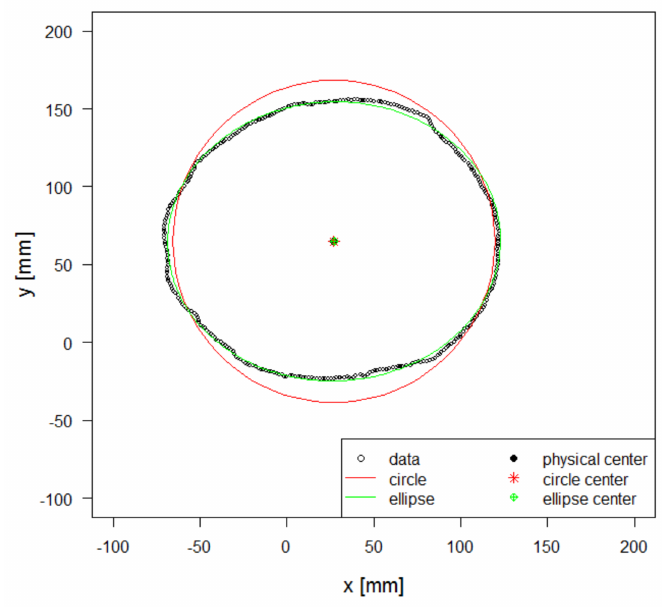
Figure 5. Visualization of physical center, least squares circle and least squares ellipse for one of the approximately 1000 slices a 5 m log is measured